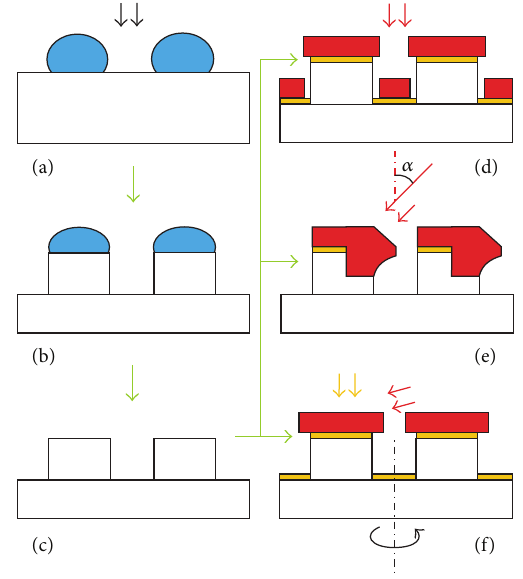
Figure 1: Schematic of the process of self-organization-based nanofabrication of stable noble-metal nanostructures on a dielectric substrate. The process consists of four steps. The fourth step is chosen to correspond to either (d), (e), or